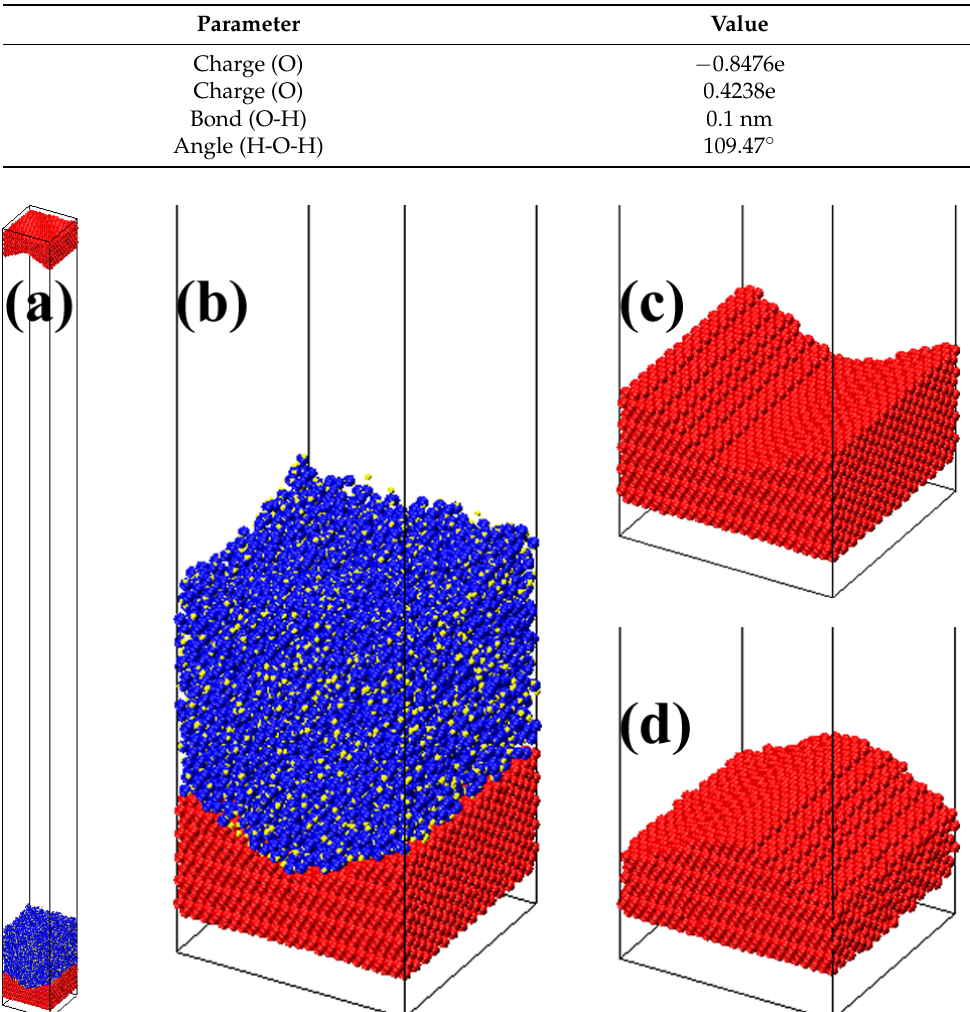
Table 1. Parameters of water molecules in SPC/E model.